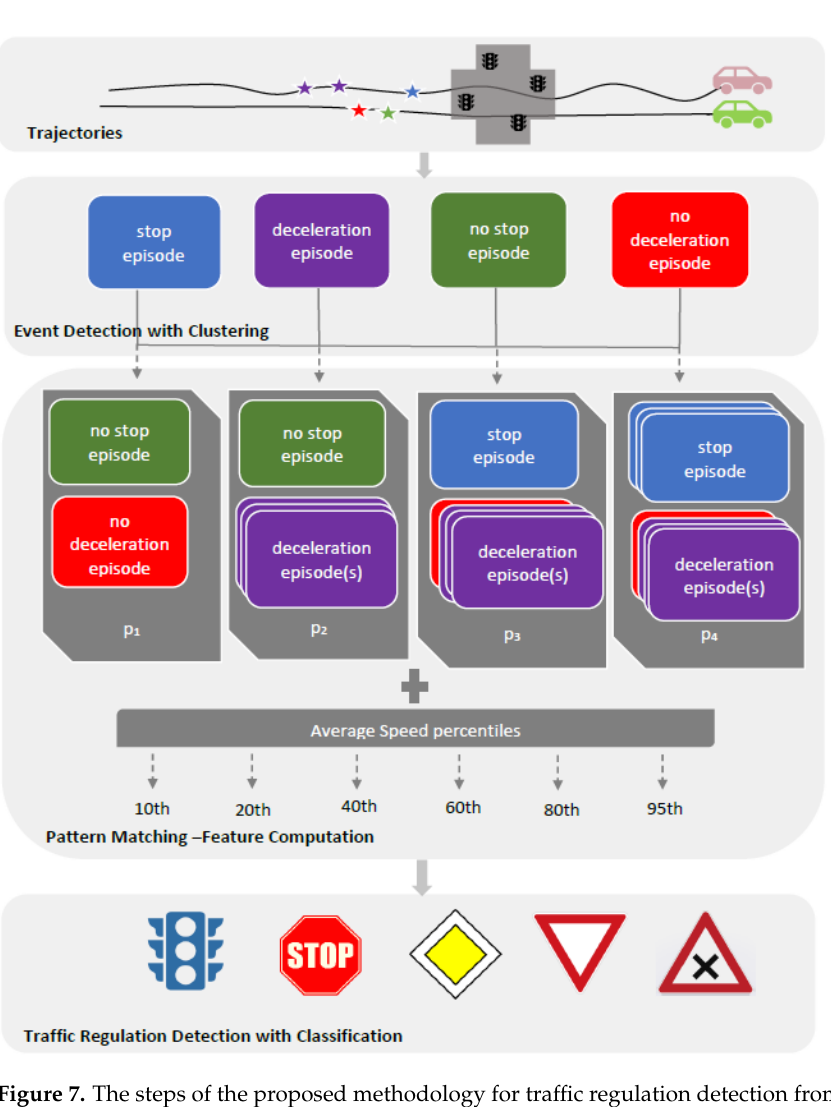
Figure 7. The steps of the proposed methodology for traffic regulation detection from GPS tracks.